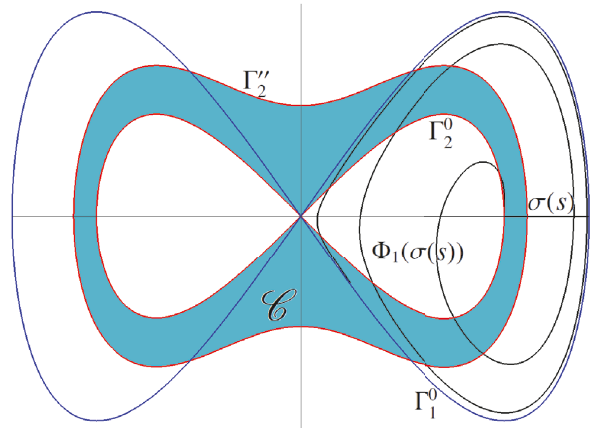
Figure 8: The present figure suggests a possible argument to prove multiplicity of sign changing solutions to the Neumann problem (94). We start with system (𝑆 1 ) by considering initial points 𝑤 0 = (𝑢 ,0) with 𝑥 < 𝑢 ≤ 𝑥 𝑃 = (𝑥 , 0) is the positive 0 01 0 1 (recall that 1 01 centerof (𝑆 1 ) ,while (𝑥 1 , 0) istheintersectionpointofthehomoclinic orbit Γ 0 1 withthepositive 𝑥 -axis).Weparameterizesuchinitialpoints as an arc 𝜎(𝑠). If 𝑇 1 is sufficiently large (with a lower bound which can be easily estimated from the equation) we find that Φ 1 (𝜎(𝑠)) is a spiral-like curve winding a certain number of times around 𝑃 1 and with an end point on Γ 0 1 in the fourth quadrant near the origin. If we fix a (small) positive constant 𝑐 󸀠󸀠 and denote by C fl {(𝑥,𝑦) : 0 ≤ 𝐸 (𝑥,𝑦) ≤ 𝑐 󸀠󸀠 } the region between the homoclinic trajectories 2 󸀠󸀠 of (𝑆 2 ) and the level line Γ 󸀠󸀠 2 fl Γ 𝑐 2 , we observe that the points of Φ (𝜎(𝑠)) ∩ Γ 0 Γ 0 Φ 1 2 , while the points 2 remain on 2 under the action of of Φ 1 (𝜎(𝑠)) ∩ Γ 󸀠󸀠 2 run around the origin along the periodic orbit Γ 󸀠󸀠 2 and will perform a certain number of revolutions if 𝑇 2 is sufficiently large.Moreprecisely,ifwedenoteby 𝜏 󸀠󸀠 theperiodof Γ 󸀠󸀠 2 andsuppose that 𝑇 2 /𝜏 󸀠󸀠 > 𝑚 , we can find solutions of (94) having precisely 2𝑗 - zeros in the interval ]𝑇 1 , 𝑇 1 + 𝑇 2 [ , for every 𝑗 = 1, .. ., 𝑚. As in the preceding figures, we have considered 𝑓(𝑥) = 𝑥 3 and 𝑉 1 = 2 , 𝑉 2 = 1. For graphical reasons a slightly different 𝑥 - and 𝑦 -scaling has been